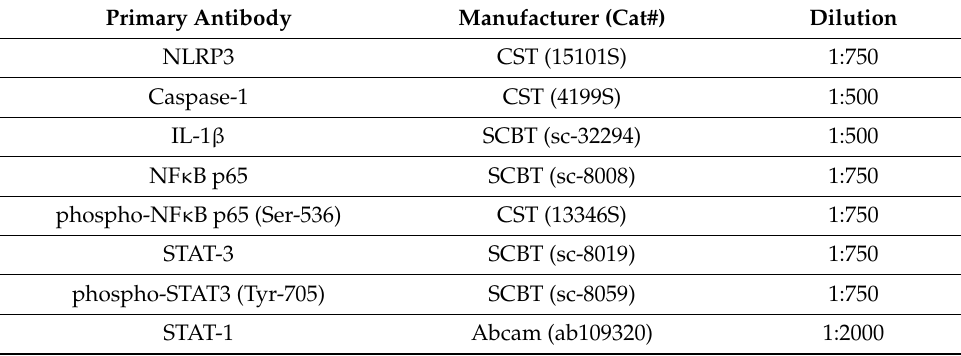
Table 1. Primary antibodies with manufacturers and